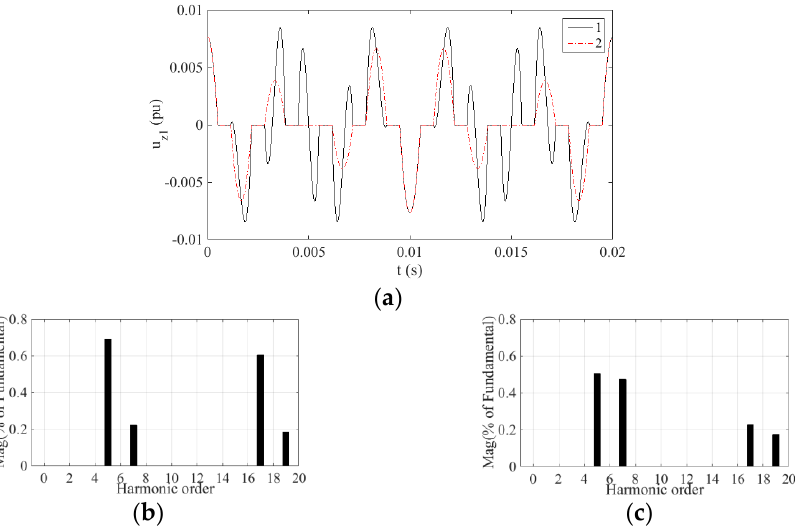
Figure 7. Simulation results u z1 of two strategies at m = 0.585. Here, 1 denotes the TFOS strategy, 2 denotes the proposed HSOS strategy: ( a ) u z1 waveforms of the two strategies; ( b ) Spectrum analysis of the TFOS; ( c ) Spectrum analysis of the proposed HSOS.